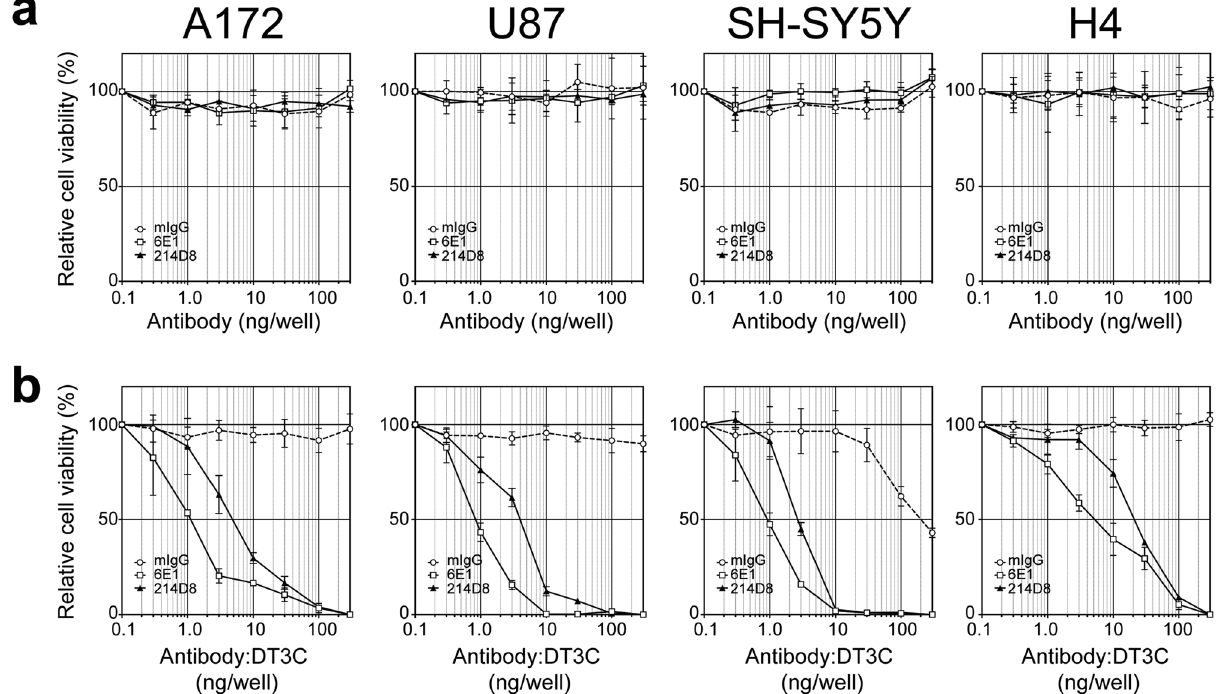
Figure 3. Dose-dependent activity of anti-CD71 immunotoxin. (a) Relative cell viability of A172, U87, SH-SY5Y and H4 cell lines after antibody treatment. Administration of antibodies did not induce cytotoxicity (n = 3 per administration). Antibody (150 kDa) at 300 ng corresponds to 13 nM. Representative results of duplicate independent experiments. Data represent AVG ± SD. (b) Relative cell viability of A172, U87, SH-SY5Y and H4 cell lines after antibody:DT3C treatment. Through formation of immunotoxins, both 214D8:DT3C and 6E1:DT3C induced cytotoxicity in all four cells lines tested (n = 3 per administration). Assuming that 2 DT3Cs (75 kDa each) bind to 1 antibody, antibody:DT3C at 300 ng corresponds to 13 nM. Representative results of duplicate independent experiments. Data represent AVG ±